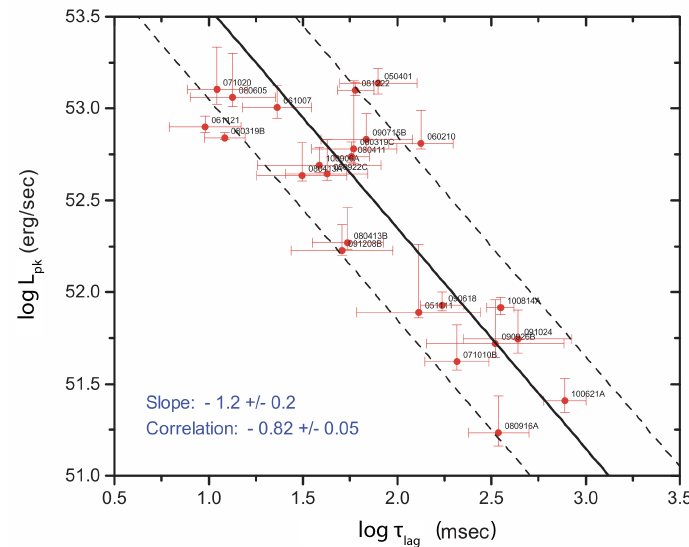
Figure 1. The L pk − τ lag taken from Ukwatta et al. [87] (Credit: Ukwatta et al., The lag–luminosity relation in the GRB source frame: an investigation with Swift BAT bursts. Monthly Notices of the Royal Astronomical Society 2012, 419, 614–623. By permission of Oxford University Press on behalf of MNRAS. ©OUP). The relationship given in Equation (8) is shown as the solid black line. The 1 σ confidence level is shown as the dashed lines, and the GRBs used in their study are shown as the red markers with 1 σ errors. The correlation coefficient for this relationship and the slope of the relationship are